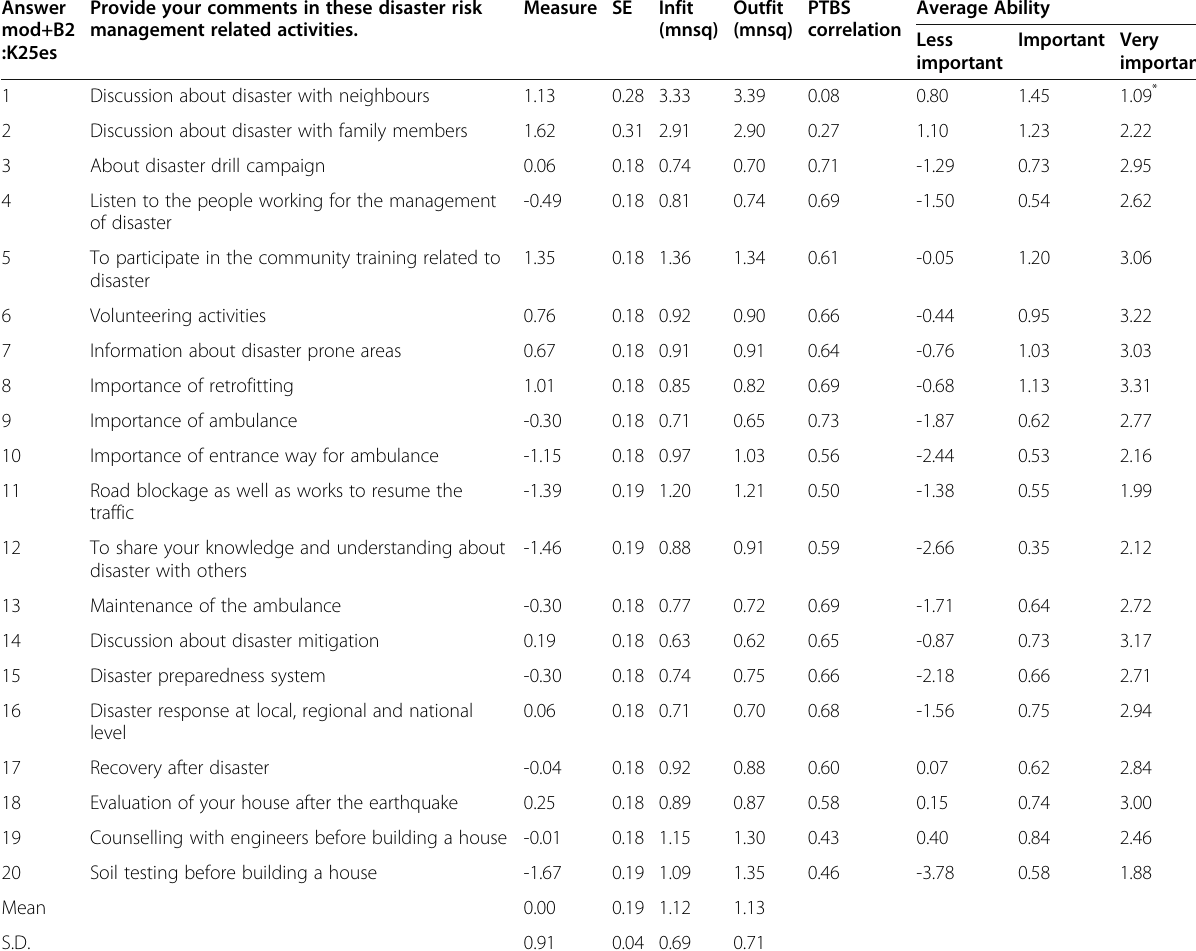
Table 5 Independent-samples T test to evaluate disaster preparedness of people in the Pokhara city after experience of the 2015 Gorkha Earthquake Answer Provide your comments in these disaster risk mod+B2 management related :K25es